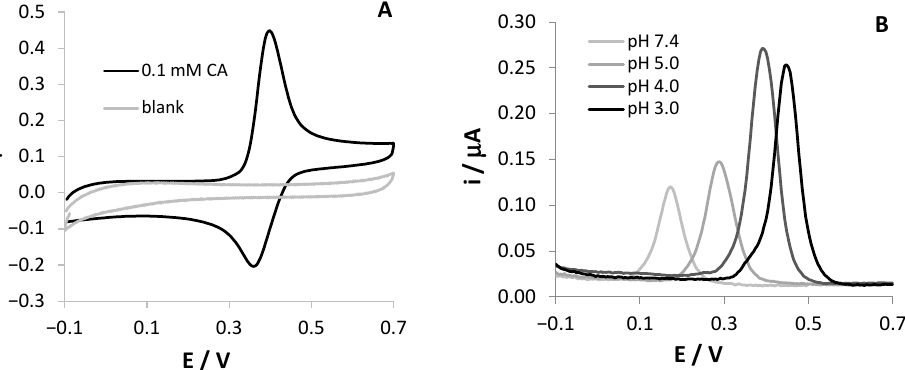
Figure 1. Voltammetric signals of 0.1 mM CA, registered at SNGC-CB electrodes: ( A ) CV scan in 0.1 M AB, pH = 4.0 solution; ( B ) DPV scans in solutions at different pH values ranging from 3.0 to 7.4.